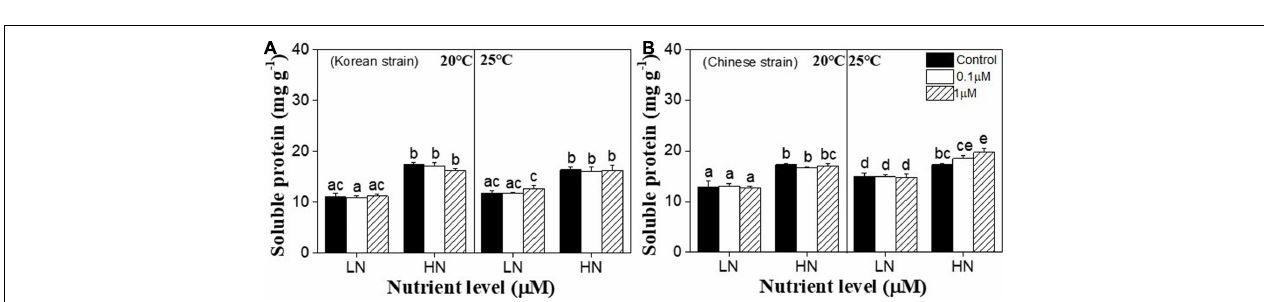
FIGURE 4 | Soluble protein contents in a Korean strain (A) and a Chinese strain (B) of Ulva prolifera cultivated under various experimental conditions. The error bars represent the standard deviation ( n = 3). Low nutrient = 50 µ M nitrate and 5 µ M phosphate (LN); high nutrient = 250 µ M nitrate and 25 µ M phosphate (HN). Different letters above the error bars represent statistical significance ( P < 0.05) among different treatments.